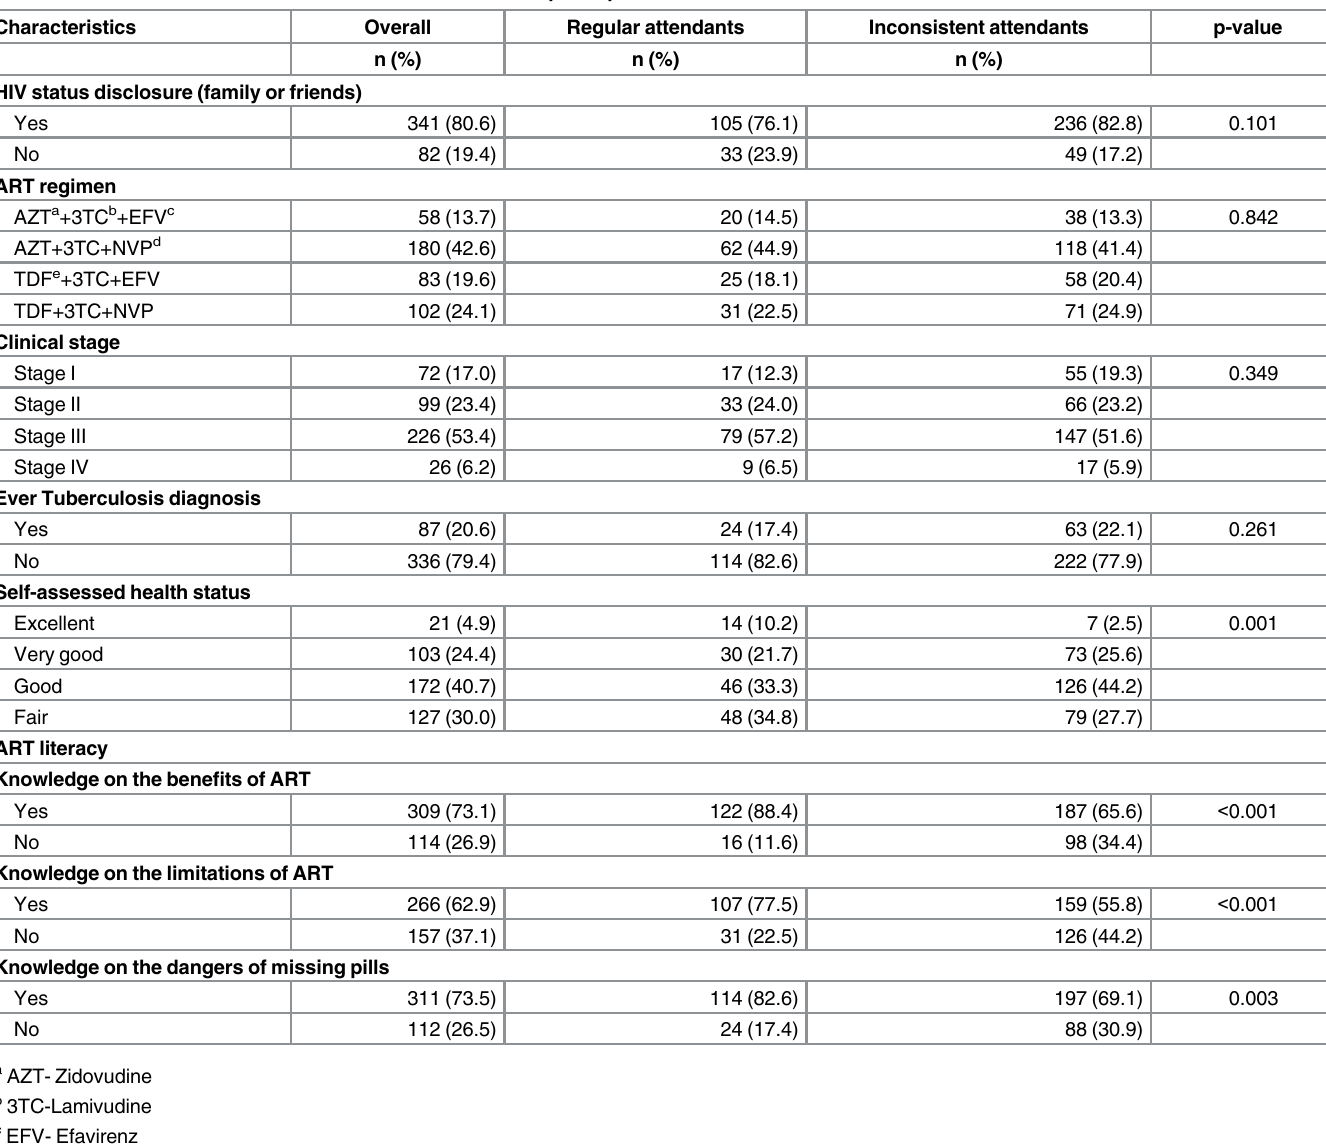
Table 2. Health and HIV status related characteristics of the participants.